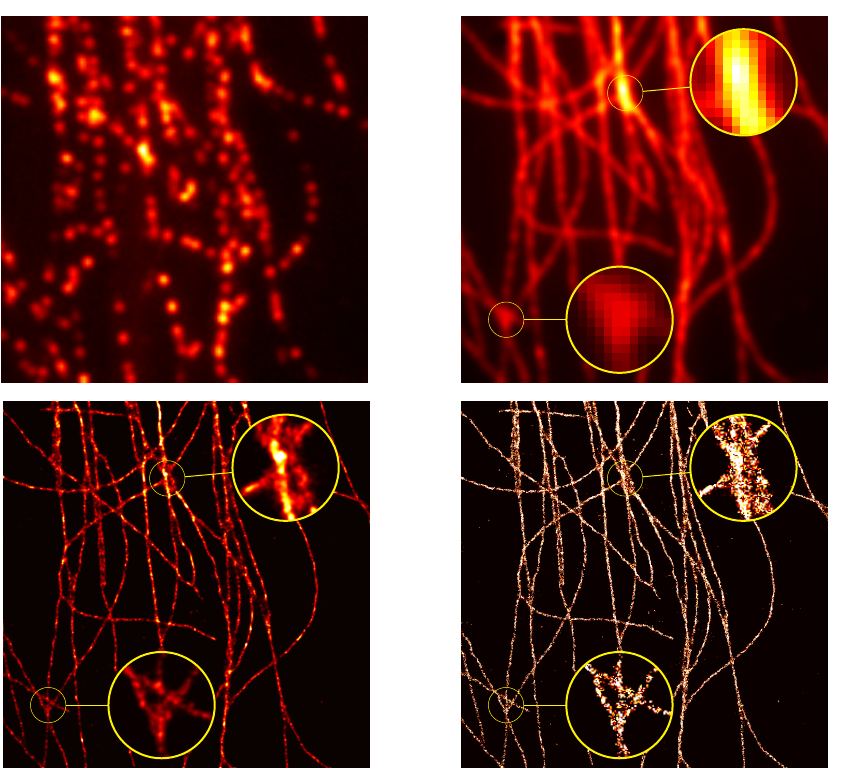
Figure 10. ( top left ) Excerpt of the stack; ( top right ) mean of the stack; ( bottom left ) reconstruction by off-the-grid method; ( bottom right )